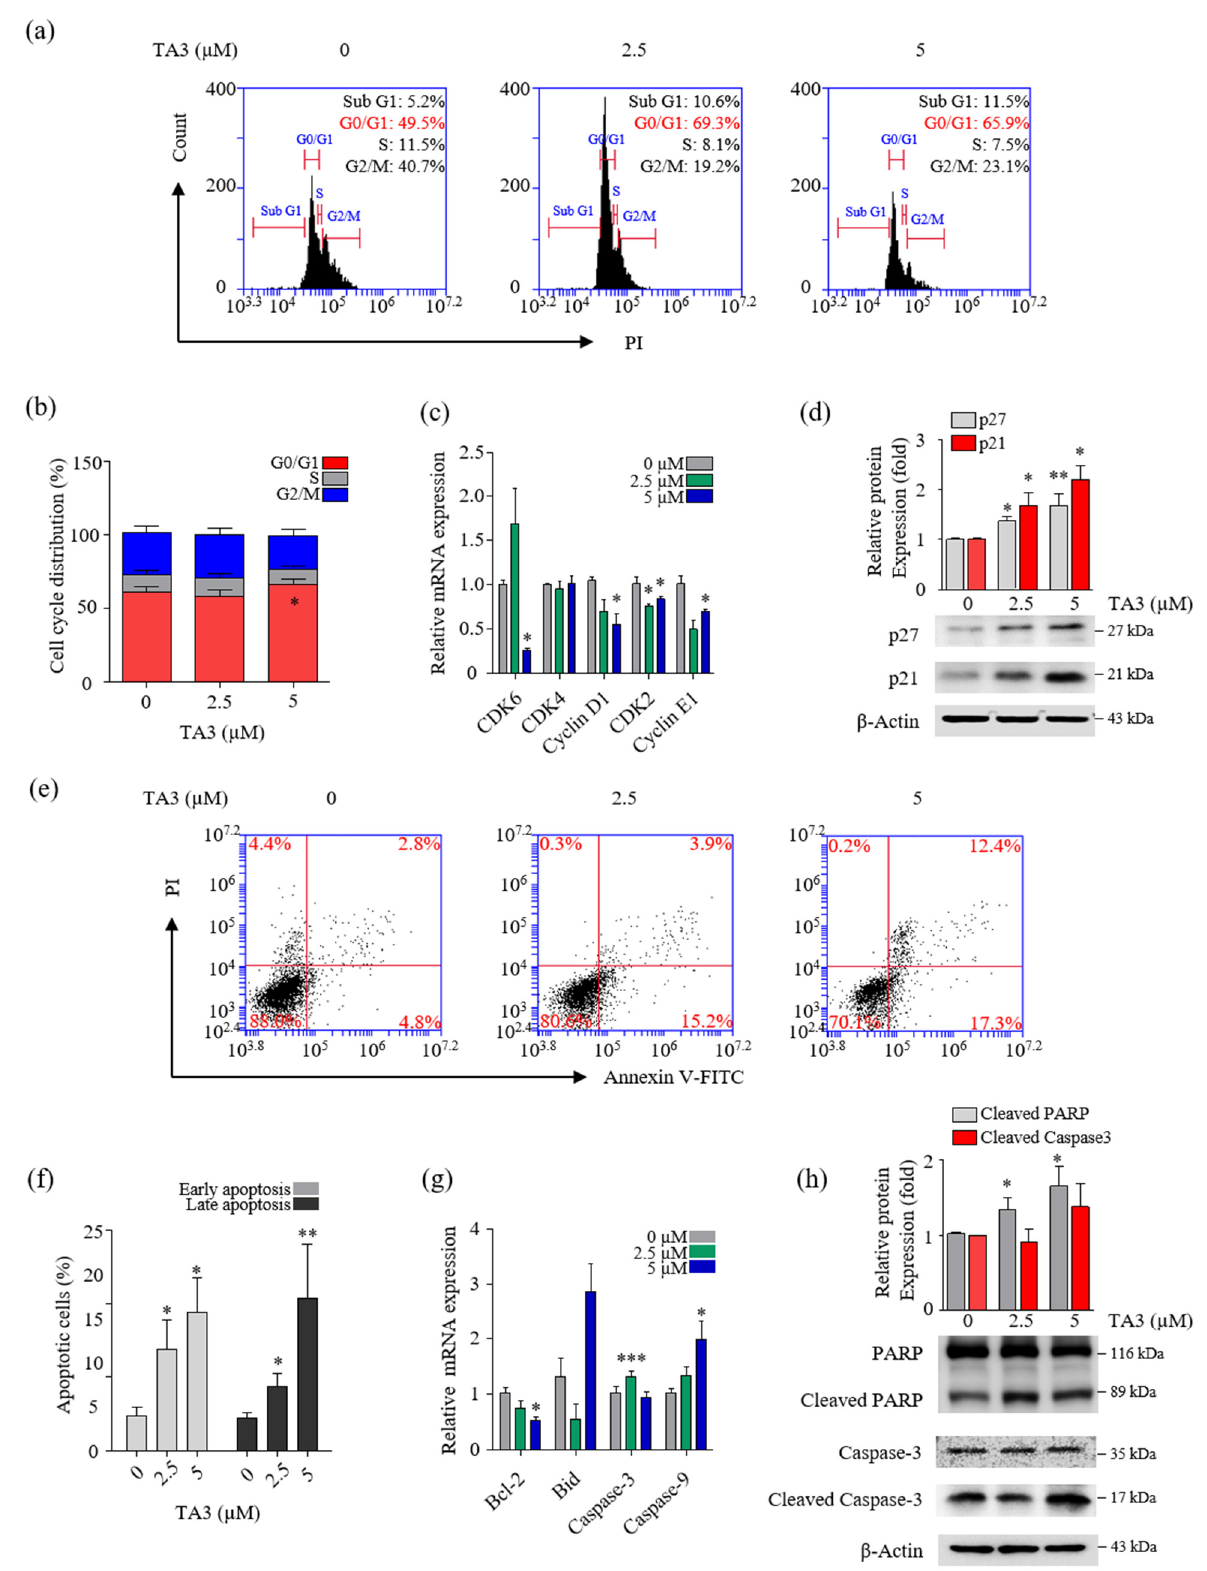
Figure 3. TA3 inhibited proliferation in BxPC-3 cells. The BxPC-3 cells were incubated with TA3 for 24 h in all assays. ( a ) Flow cytometry was used to analyze PI-stained cells and ( b ) the results were presented in the bar chart as the mean ± SD of the independent three experiments (* p < 0.05 vs. control). ( c ) The G1/G0-phase-related genes’ mRNA levels were analyzed using qRT-PCR. ( d )